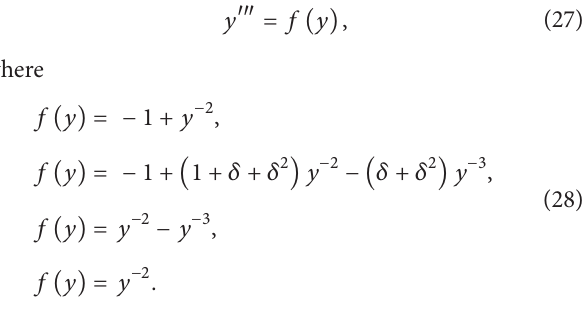
ℎ = 0.005 . It is obvious that BHCM requires less steps to obtain the solutions compared to Awoyemi methods [7,